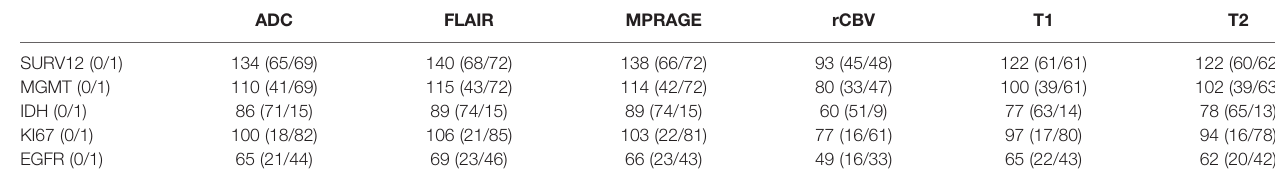
TABLE 1 | Number of patients and label distributions for label-sequence combination. ADC FLAIR MPRAGE rCBV T1 T2 SURV12